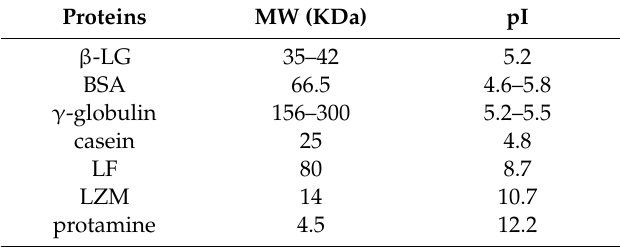
Table 2. Physical properties of proteins used in this